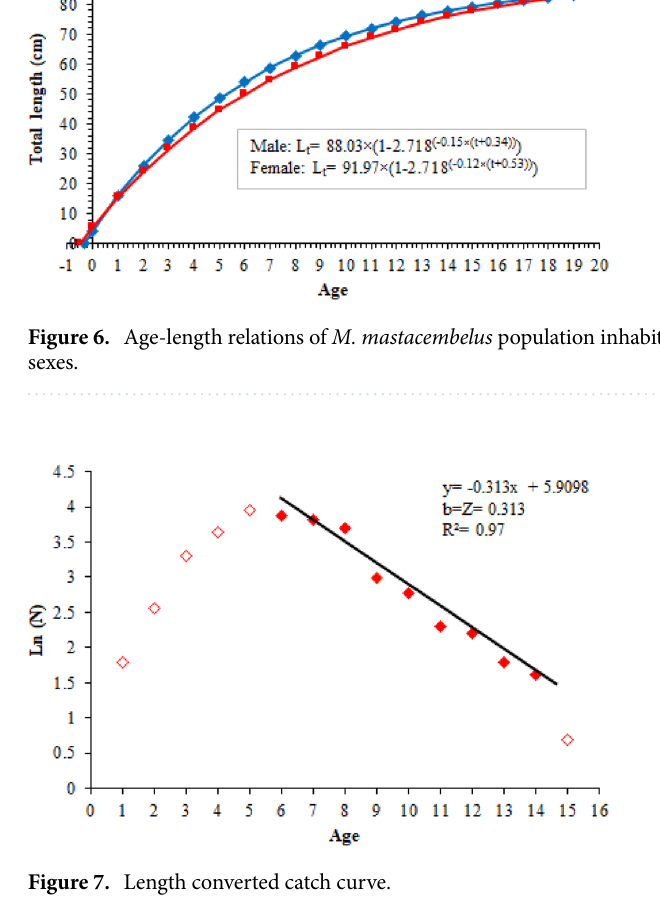
Figure 7. Length converted catch curve.